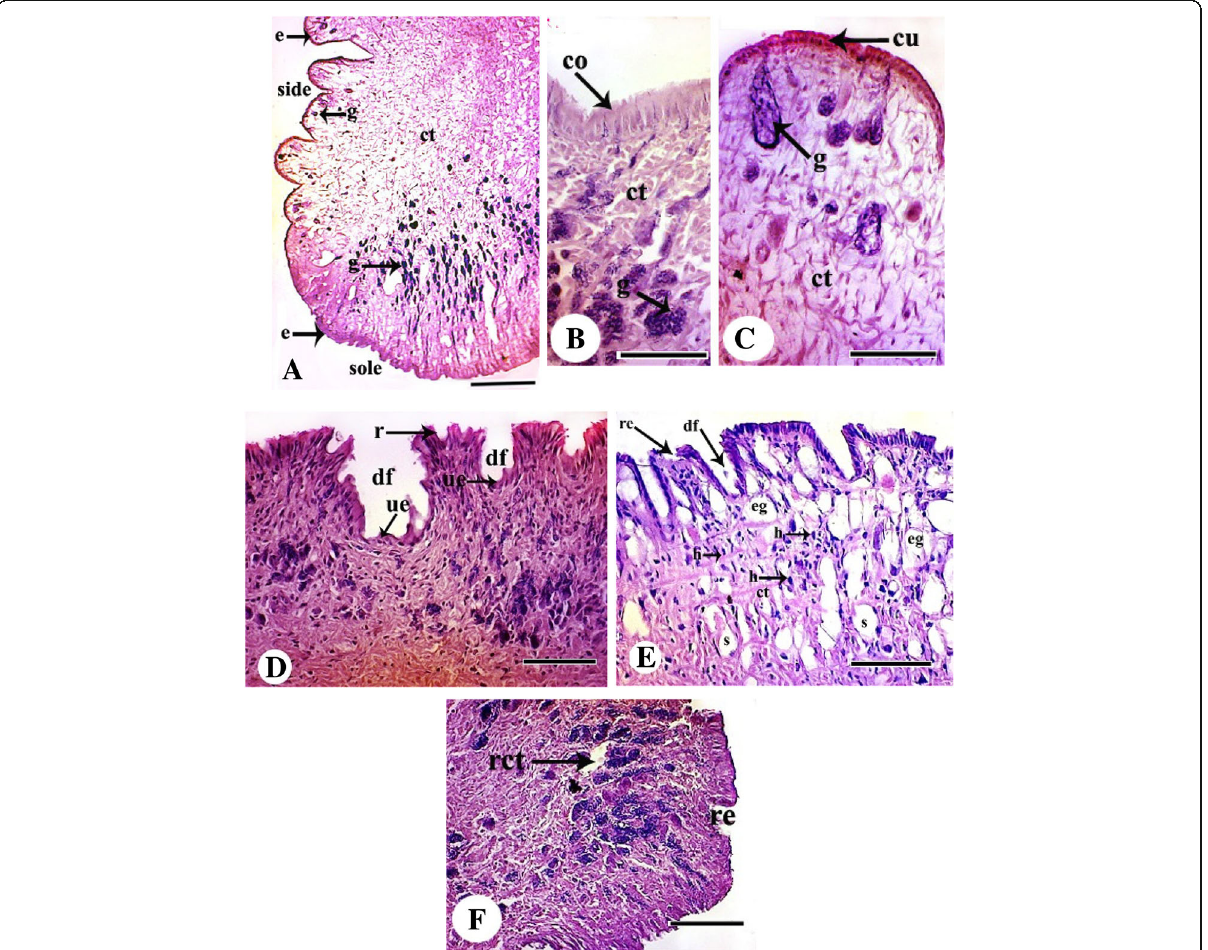
Fig. 3 A Photomicrograph of the foot of Monacha obstructa showing side and sole of the foot are covered with epithelial layer (e), the inner connective tissue layer (ct), and glands embedded in the connective tissue (g). B , C Photomicrographs of the foot of Monacha obstructa showing B the foot sole is covered with simple columnar epithelium (co), and the connective tissue layer (ct) with many deeply embedded glands (g). C The side of the foot is covered with simple cuboidal epithelium (cu), and the connective tissue layer (ct) with few superficial glands (g). D , E Photomicrograph of the foot of Monacha obstructa exposed to UV-A for 3 h for two successive days showing D the sole of the foot with ruptured epithelial cells (r), deep folds (df), and undifferentiated epithelial cells (ue). E The foot sides with ruptured epithelial cells (re), deep folds (df), many empty glands (eg), the connective tissue layer (ct) with many empty spaces (s), and infiltrated hemocytes (h). F , G Photomicrograph of the foot of Monacha obstructa exposed to UV-A for 3 h for three successive days showing F the sole of the foot with ruptured connective tissue (rct) and ruptured epithelial layer (re). G The side of the foot with separated epithelial layer (se) disintegrated glands